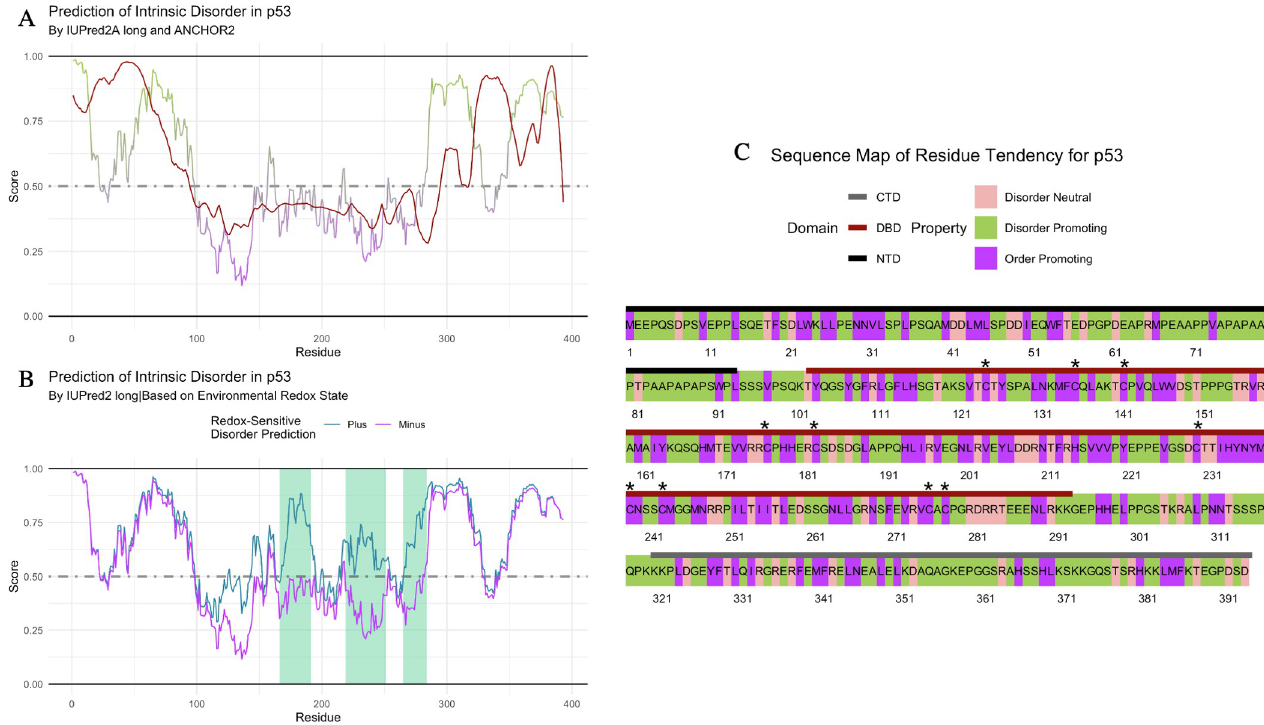
Fig 2. Disorder predictions for p53domainsrecapitulate environmentalsensitivities. (A) IUPred2A predictsmultipleIDRs thatpromoteprotein-protein interactions in p53[23,24].Residueswith anIUPred2score(greenandpurpleline)of 0.0–0.5are predictedto be orderedandresidues0.5–1.0are predictedto be disordered.Residueswithan ANCHOR2score(redline)greaterthan 0.5are predictedto be IDRsand protein-bindingdomains.(B)IUPred2A Redoxpredictsseveral oxidation-sensitiveregionsin p53[23,24].Redox-plus (reducingenvironment) predictionsareshown inblue,Redox-minus(oxidizingenvironment) predictionsare showninpurple.Regions predicted as“RedoxSensitive”are highlighted inlight green.Residueswith anIUPredscoreof0.0–0.5are predictedto beorderedand residues0.5–1.0are predicted to bedisordered.(C) Sequencemapofstructuraltendencyfor each residuehighlightsthe composition of p53domains.N-terminal Domain(NTD)annotatedbythe blackbar,DNA-BindingDomain(DBD)annotatedby theredbar, C-terminal Domain(CTD)annotatedby the greybar.Conserved Cys residues(C124,C135,C141, C176,C182,C229,C238,C242,C275,C277]annotated[42].Disorder-promotingresidues(P,E,S, Q,K,A, andG) highlighted in green;order-promotingresidues (M,N,V, H, L, F,Y,I, W,andC) inpurple;disorder-neutral residues(D, T,and R)in pink[35].